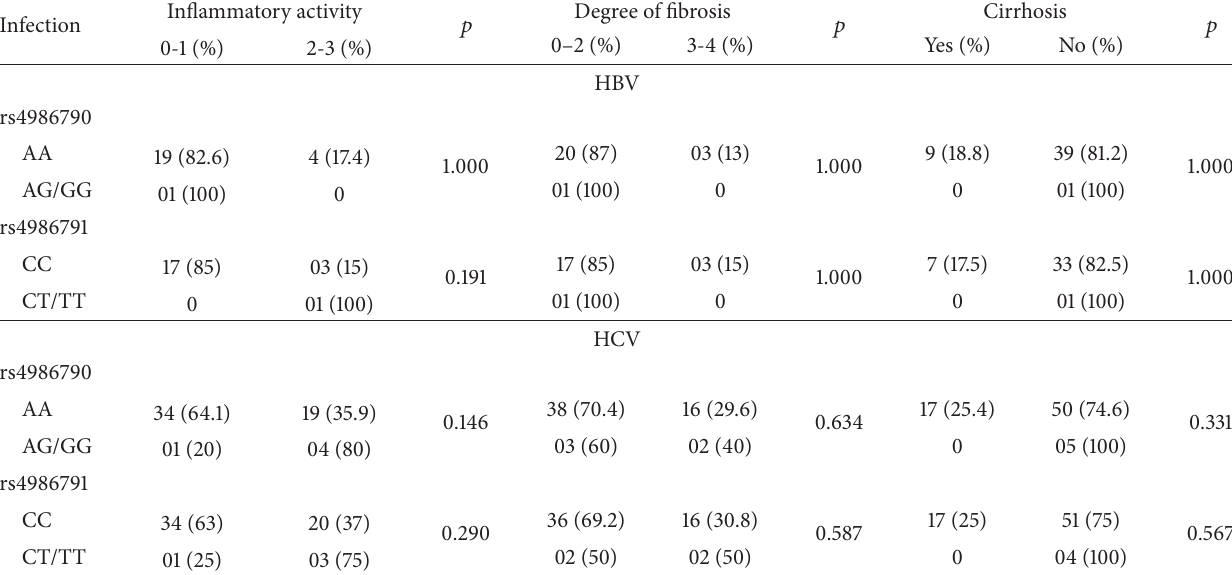
Table 3: Association of polymorphisms of the TLR4 gene with inflammatory activity, degree of fibrosis, and liver cirrhosis in chronic HBV and HCV